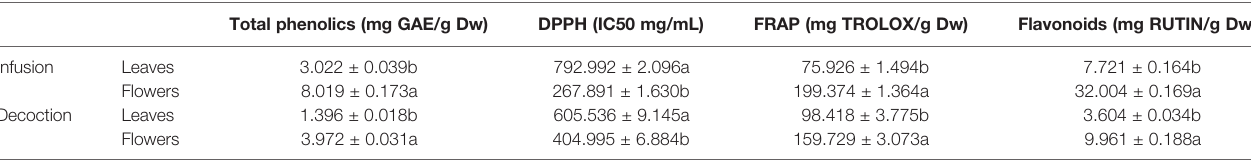
TABLE 2 | Total phenolics and fl avonoids content and bioactive compounds of infusion and decoction of S. cypria